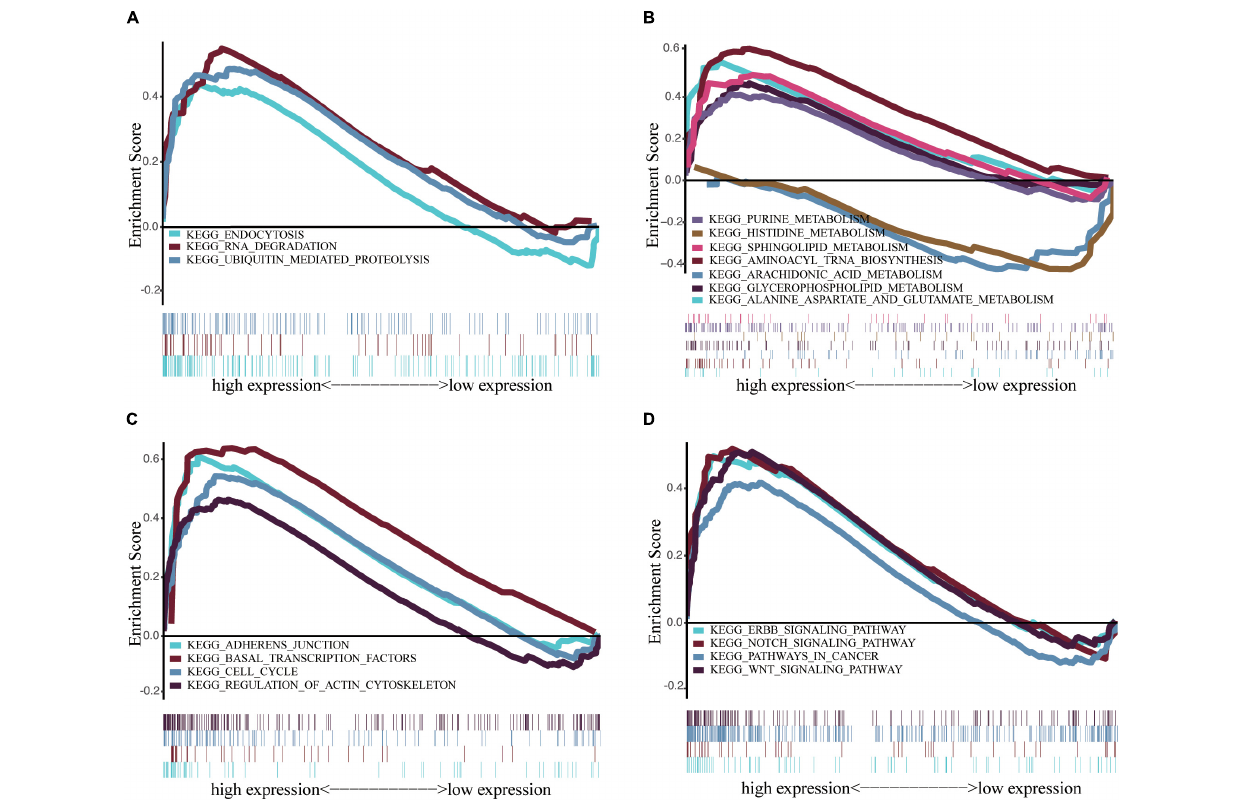
FIGURE 6 | Enrichment plots from multiple GSEA. (A) Scavenging and degradation: Endocytosis, RNA degradation and ubiquitin mediated proteolysis. (B) Synthesis and metabolism: Alanine aspartate and glutamate metabolism, aminoacyl tRNA biosynthesis, arachidonic acid metabolism glycerophospholipid